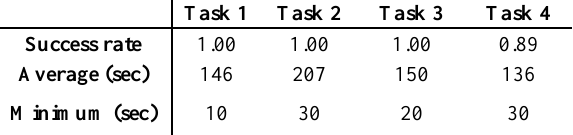
Table 5. Usability test task